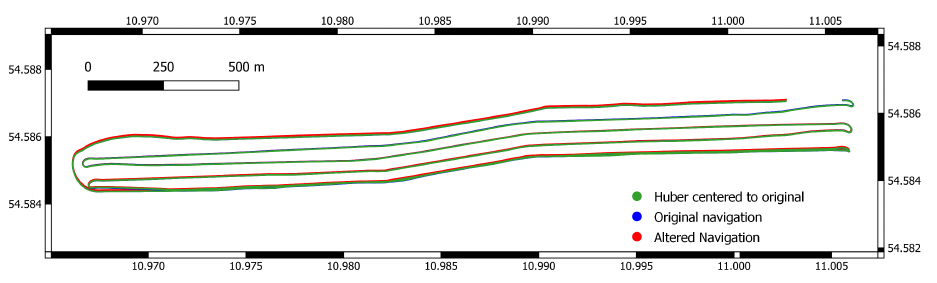
Figure 9. Original and altered navigation alongside the renavigated solution centered towards the original navigation using Huber loss for trial 1.